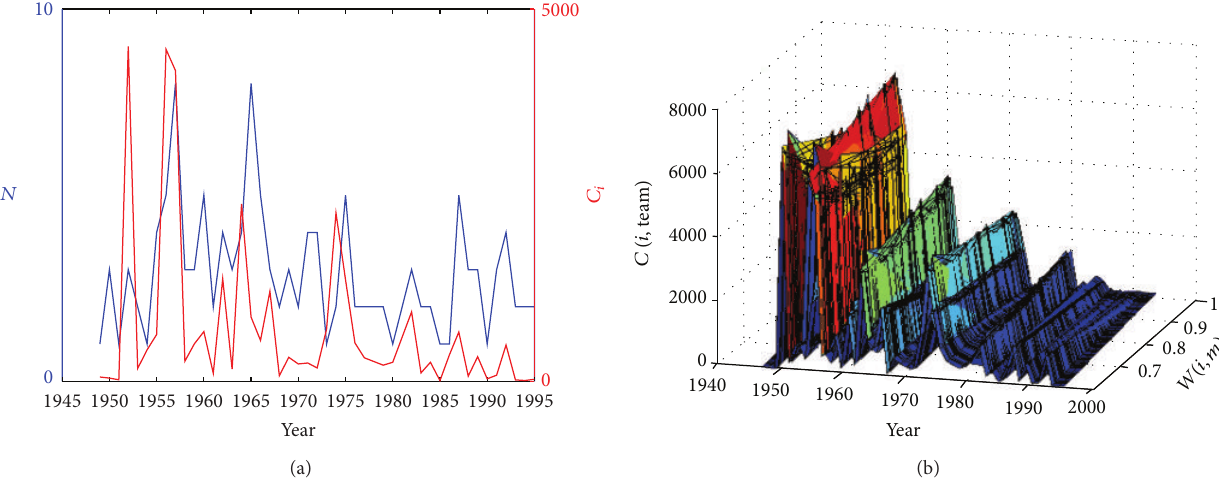
Figure 5: Total articles 𝑁 and innovation ability 𝐶 𝑖 for TD Lee’s cooperator. (a) 𝑁 and 𝐶 𝑖 versus year; (b) ( 𝐶(𝑖, team ),𝑊(𝑖,𝑚) ) versus